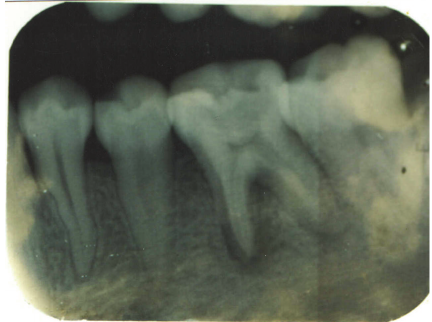
Figure 6: Before operation (46).